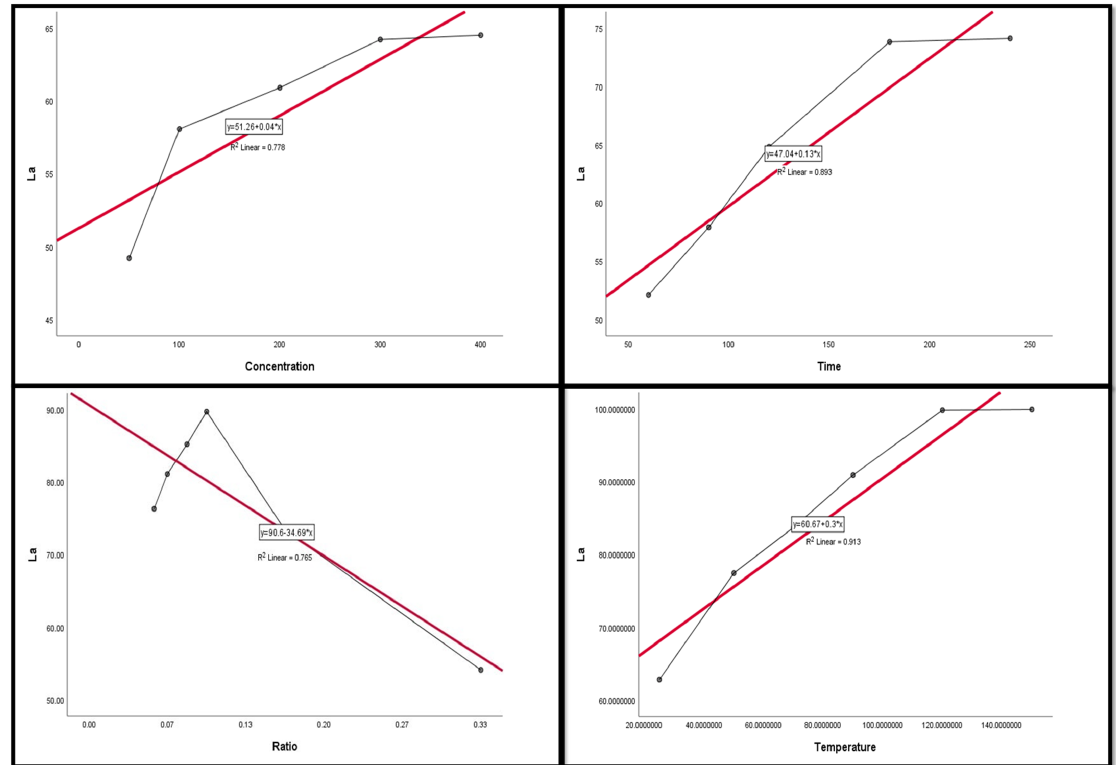
Figure 10. The scatter plot with linear regression fit for La leaching efficiency, %, and factors.